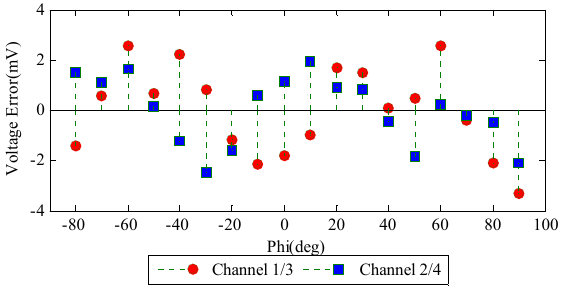
Figure 7. The error between the fitting curve and output voltages. The remaining voltage errors are within ±4 mV which are due to the output offset voltages of the two log ratio amplifiers (typical value ±3 mV) and the noises of other circuit components. This random voltage error is hard to compensate.